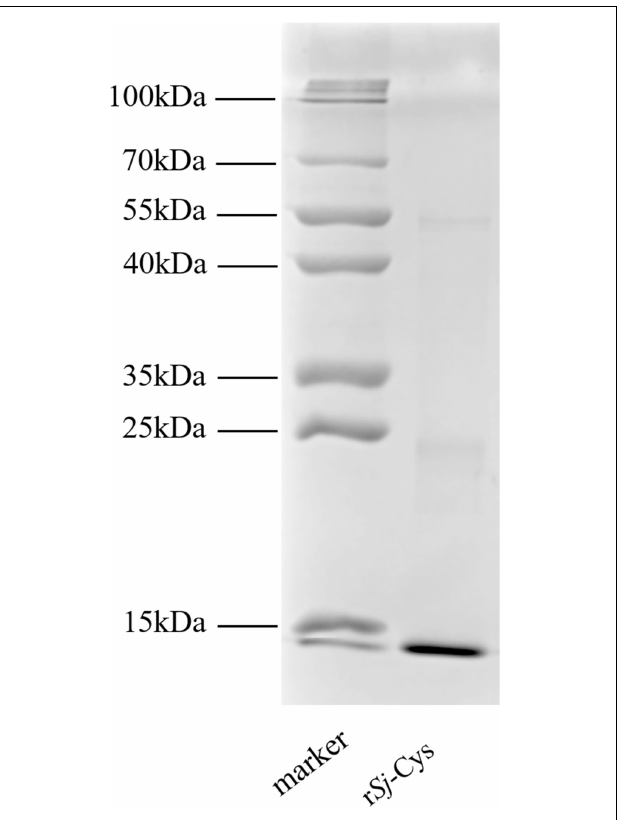
FIGURE 1 | SDS-PAGE of r Sj -Cys. Two micrograms of purified r Sj -Cys was separated in 12% polyacrylamide